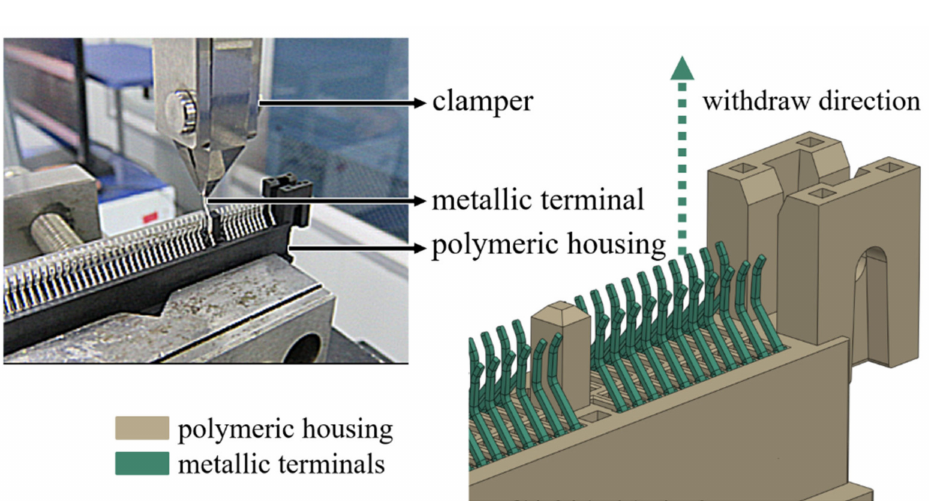
Figure 3. A drawing of SSD connector.